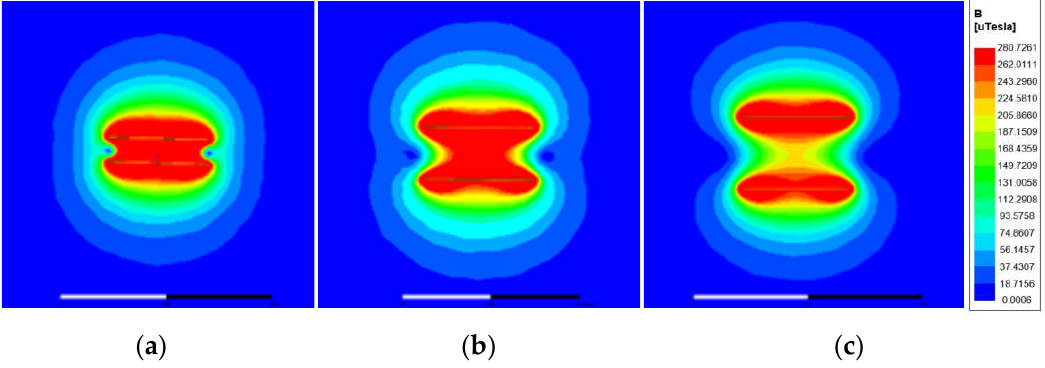
Figure 10. The magnetic flux density distribution of WPT system with no shielding: ( a ) 50 mm; ( b ) 100 mm; ( c ) 150 mm.